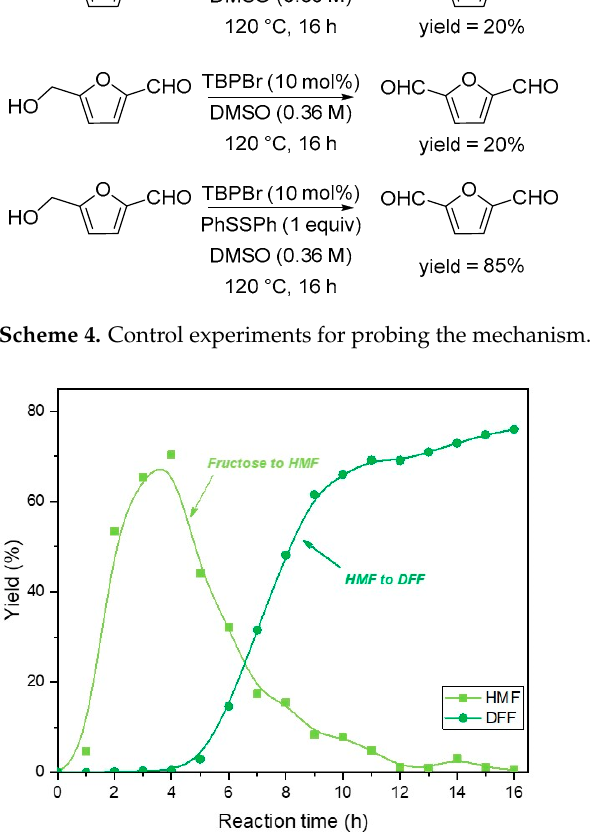
Figure 2. Reaction profile for converting D-fructose to DFF via HMF; TBPBr (10 mol%) and PhSSPh (1 equiv) were added to the solution of D-fructose in DMSO.